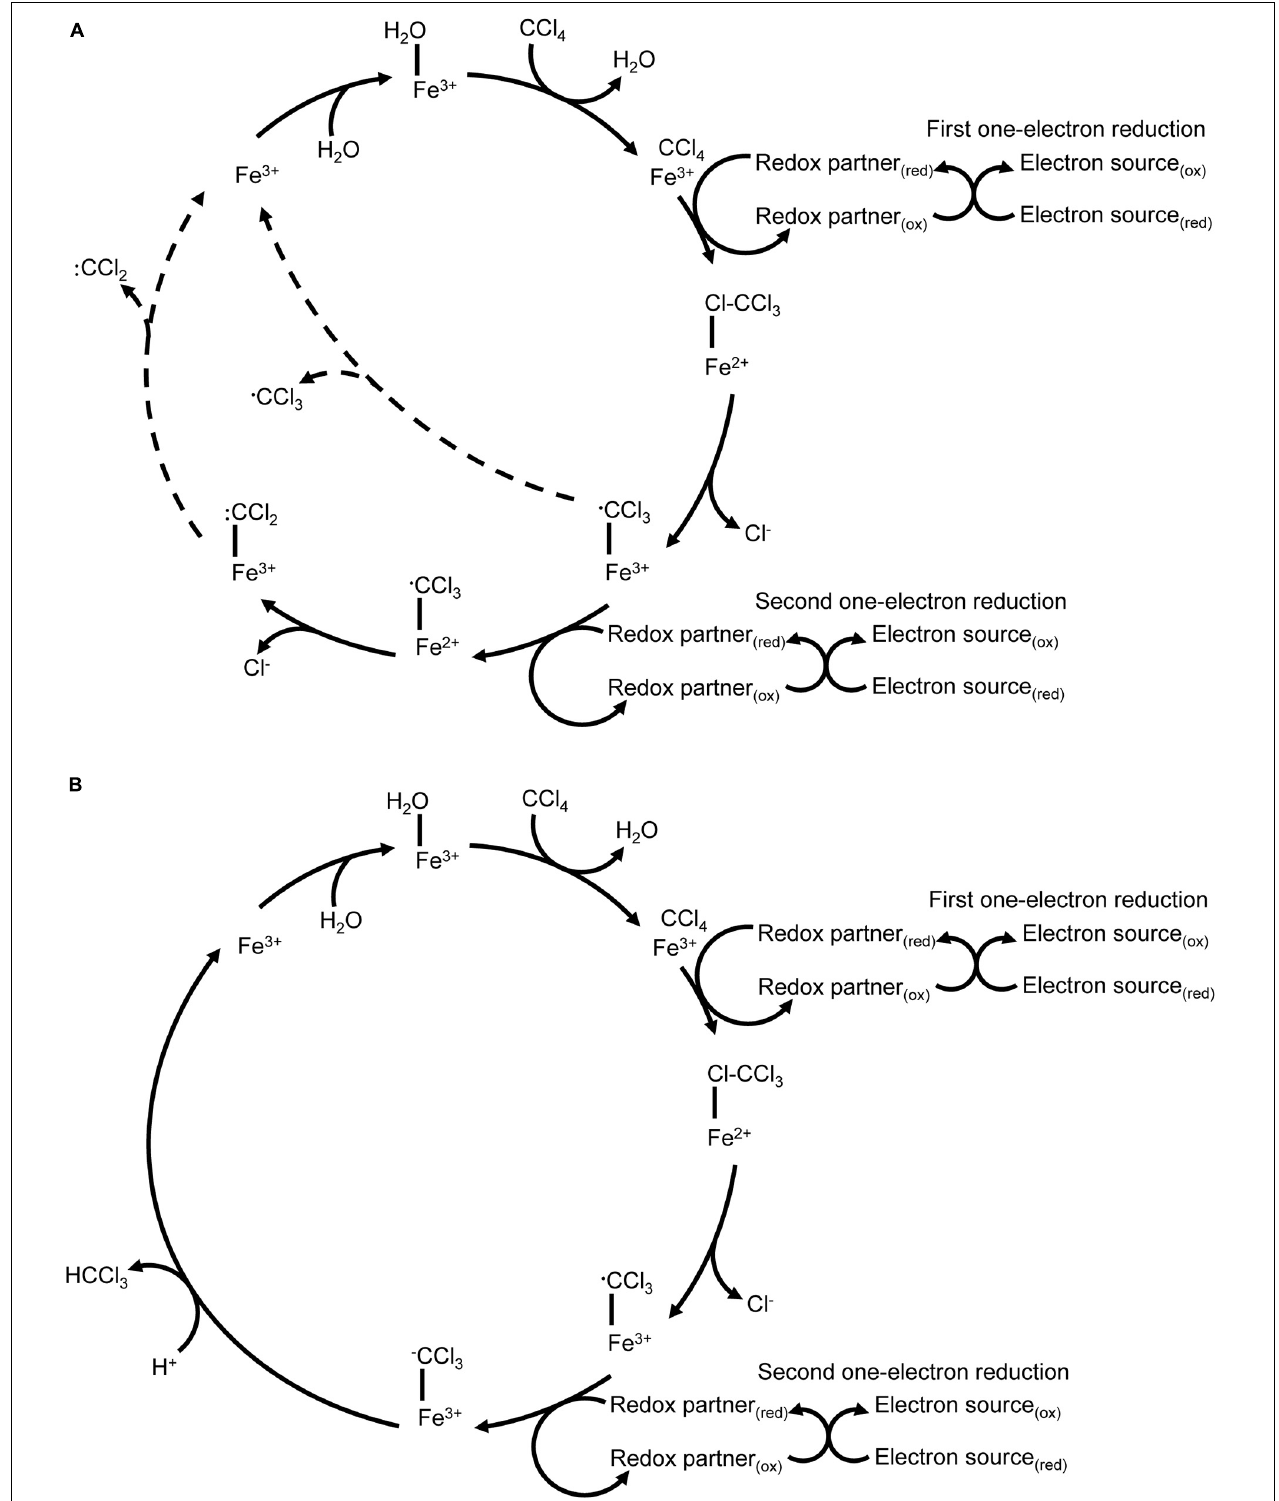
FIGURE 4 | Reductive dechlorination of carbon tetrachloride. (A) P450 2E1 catalyses a one-electron reduction of carbon tetrachloride that results in release of chloride and formation of a carbon trichloride radical. The reaction cycle may uncouple with release of the carbon trichloride radical. A second one-electron reduction without protonation has also been reported, resulting in a carbon dichloride radical. Uncoupling events with release of radicals are indicated with dashed lines. (B) P450 CAM catalyses a two-electron reduction of carbon tetrachloride to yield carbon trichloride.